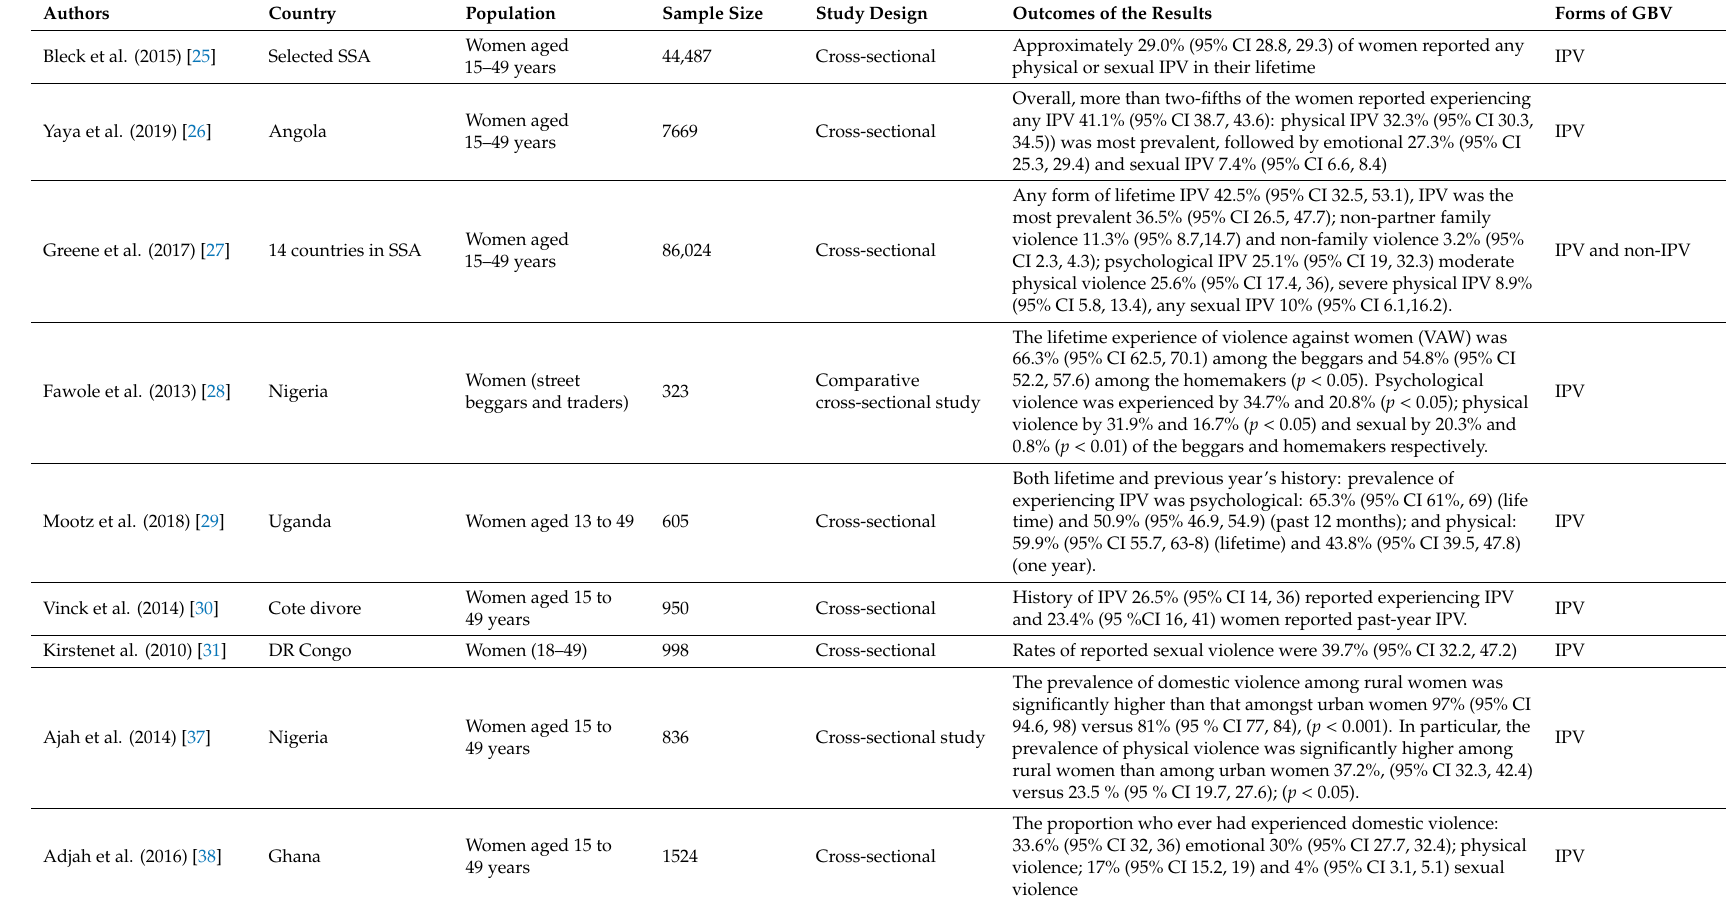
Table 1. Characteristics of included studies (intimate partner violence (IPV) and